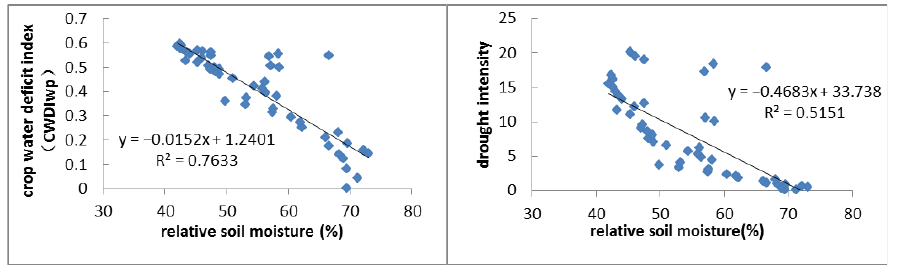
Figure 3. Relationships between and relative soil moisture content and drought intensity and CWDIwp.